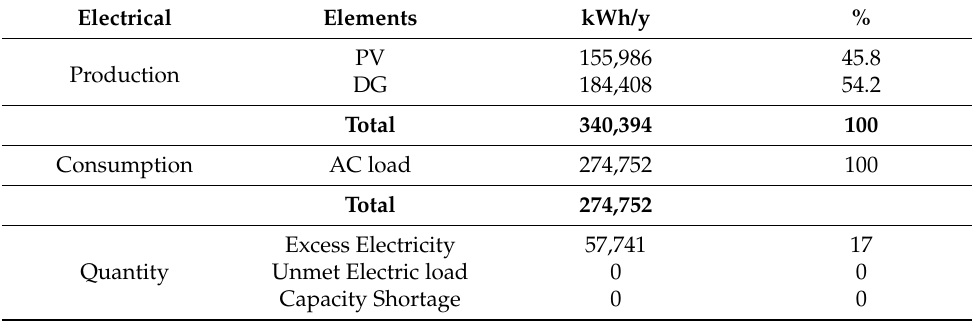
Table 6. Augmented Electrical Result for